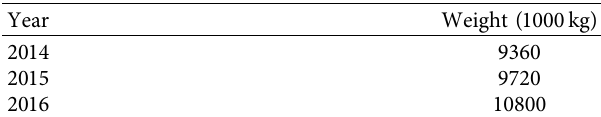
Table 4: Landfill waste input for Germi from 2014 to 2016.